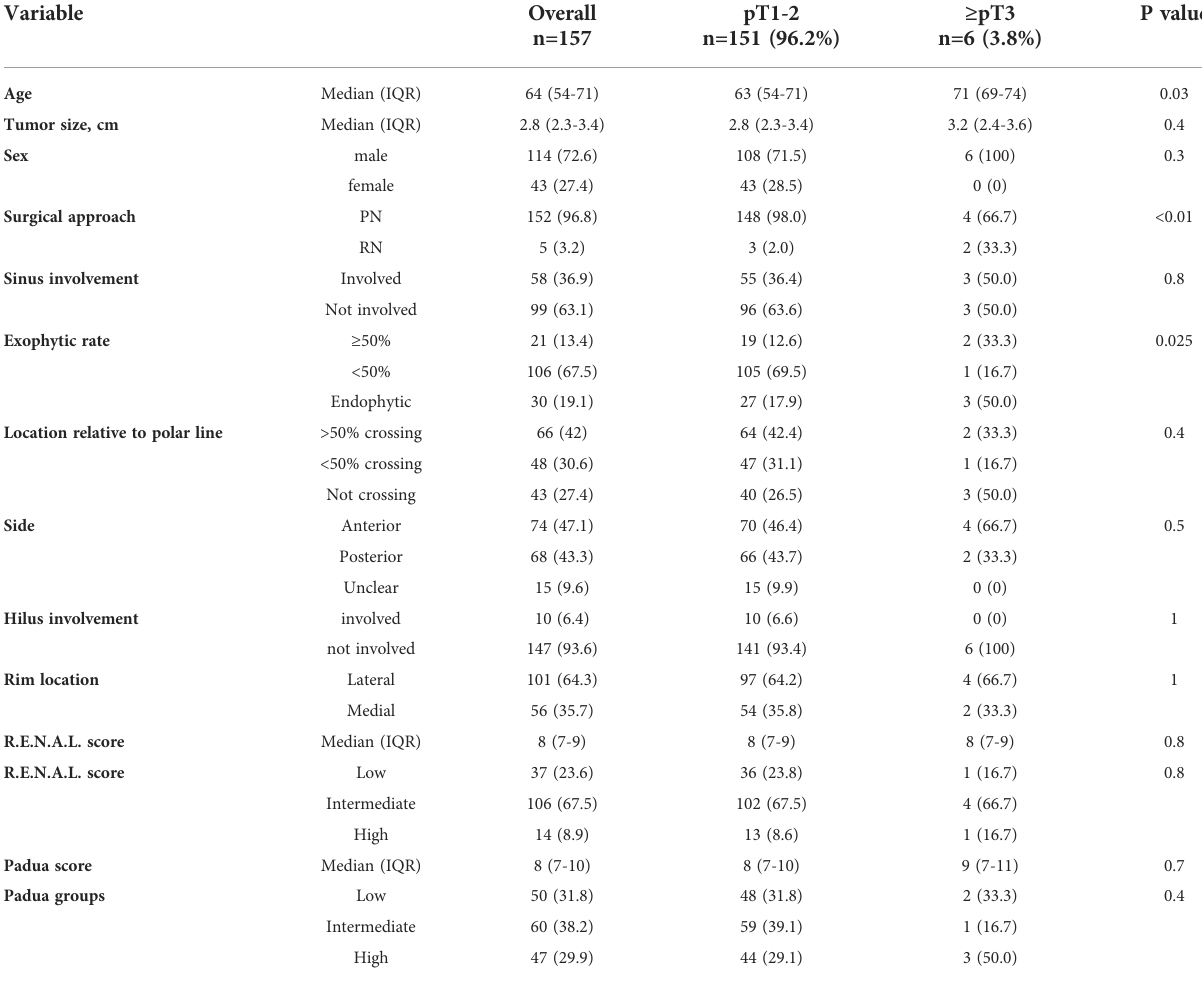
The accuracy of the external validation of the Nocera nomogram resulted in 76.6% of ≥ pT3 prediction, relying on the clinical and radiographic variables of age at diagnosis, tumor size, rim location, exophytic rate and polar involvement. The relationship between predicted probability by the Nocera nomogram of ≥ pT3 ccRCC and observed of ≥ pT3 ccRCC rates is depicted in the calibration plot (Figure 1). Here, the nomogram predicted values overestimated the risk of ≥ pT3 ccRCC at values >10%. DCA graphically depicted the TABLE 2 Descriptive characteristics of 157 small renal mass (SRM, cT1a) clear cell renal cell carcinoma patients, surgically treated between 2008- 2021 at the University Hospital Frankfurt, strati fi ed according to pT1-2 vs. ≥ pT3